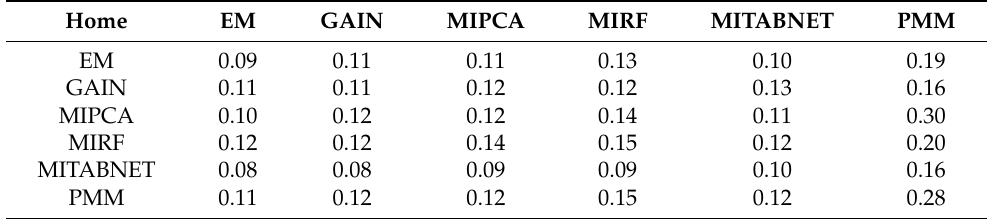
Table 7. Interval width for each imputation algorithm in the Flatiron NSCLC